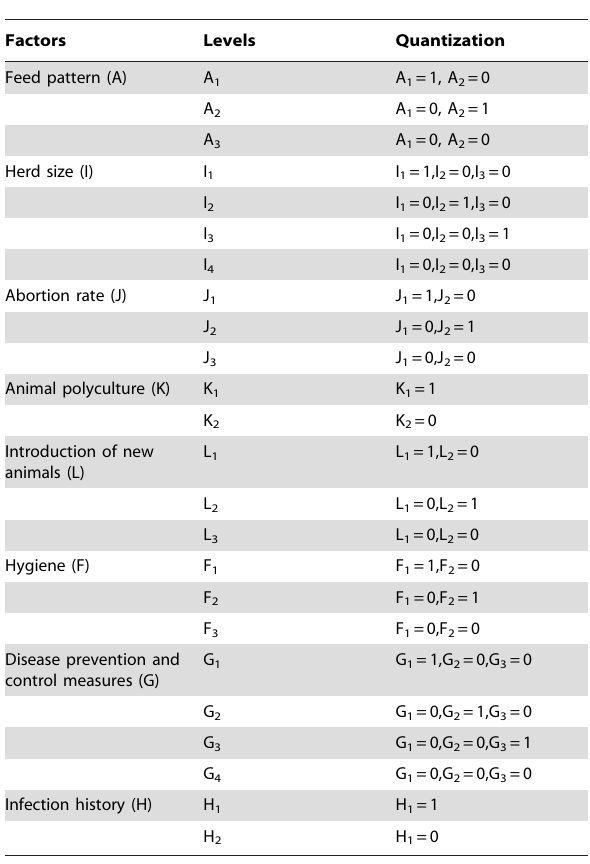
Table 4. Quantization for each level of risk factor.